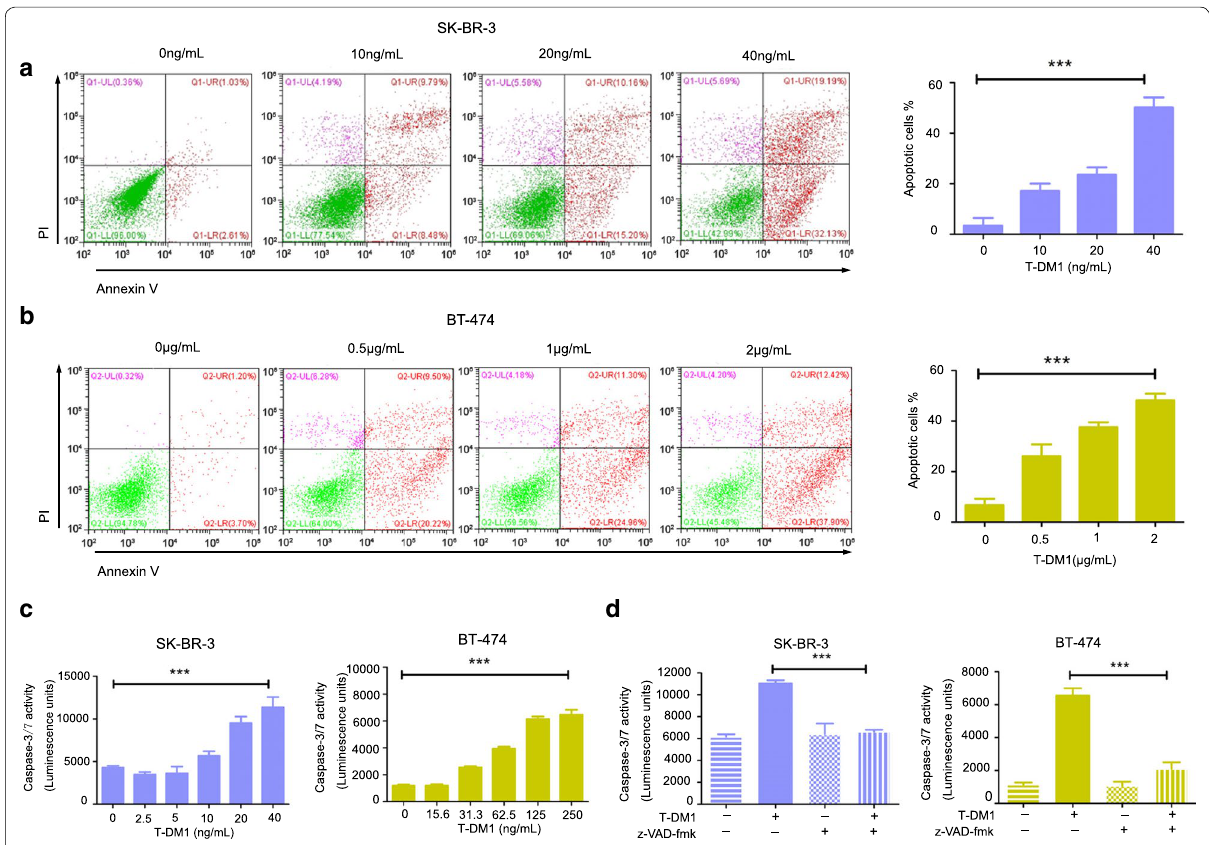
Fig. 1 T-DM1 induced apoptosis and Caspase-3/7 activation in SK-BR-3 and BT-474 cells. a , b Cells were incubated with T-DM1 for 2 days,